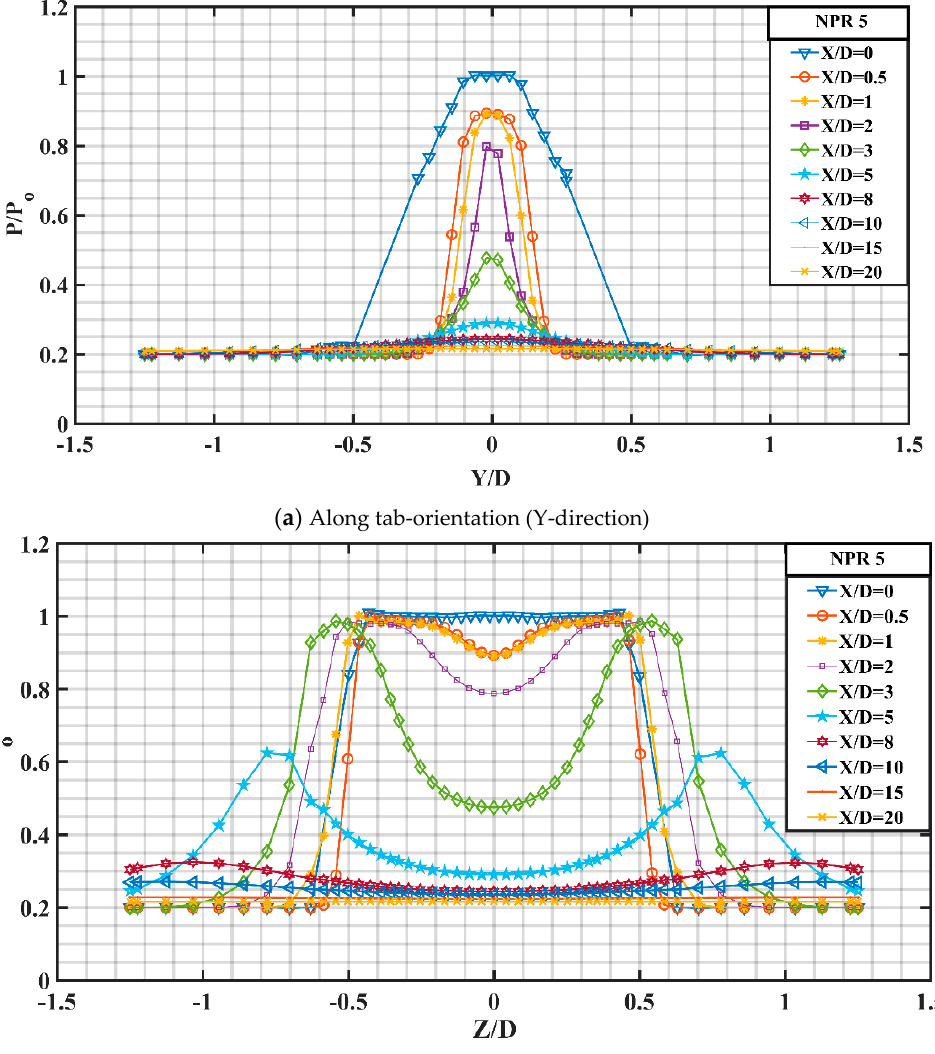
Figure 19. Pressure profile variation for controlled jet at NPR 5.